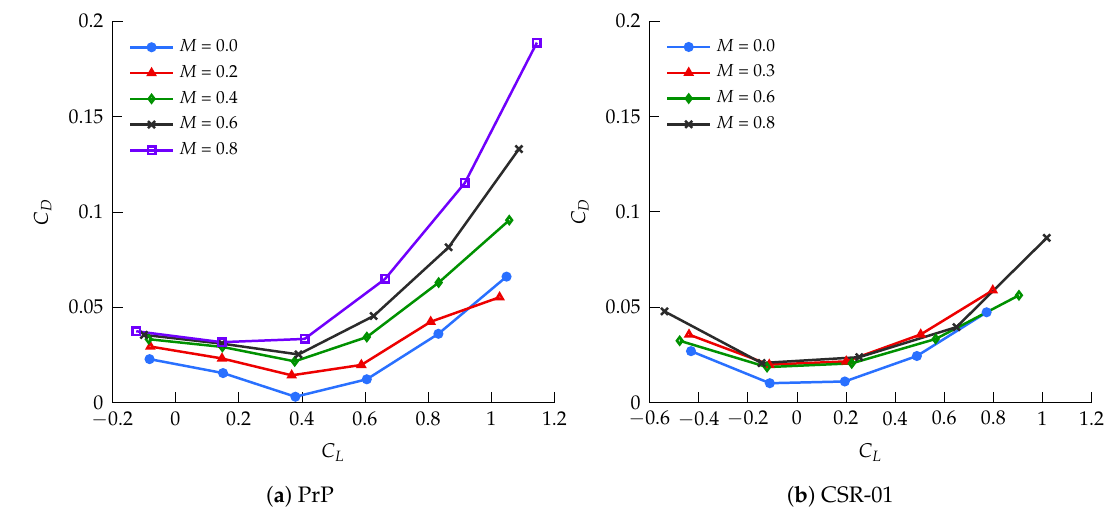
Figure 2. The lift-drag polar of the ( a ) PrP and ( b ) CSR-01 as a function of Mach